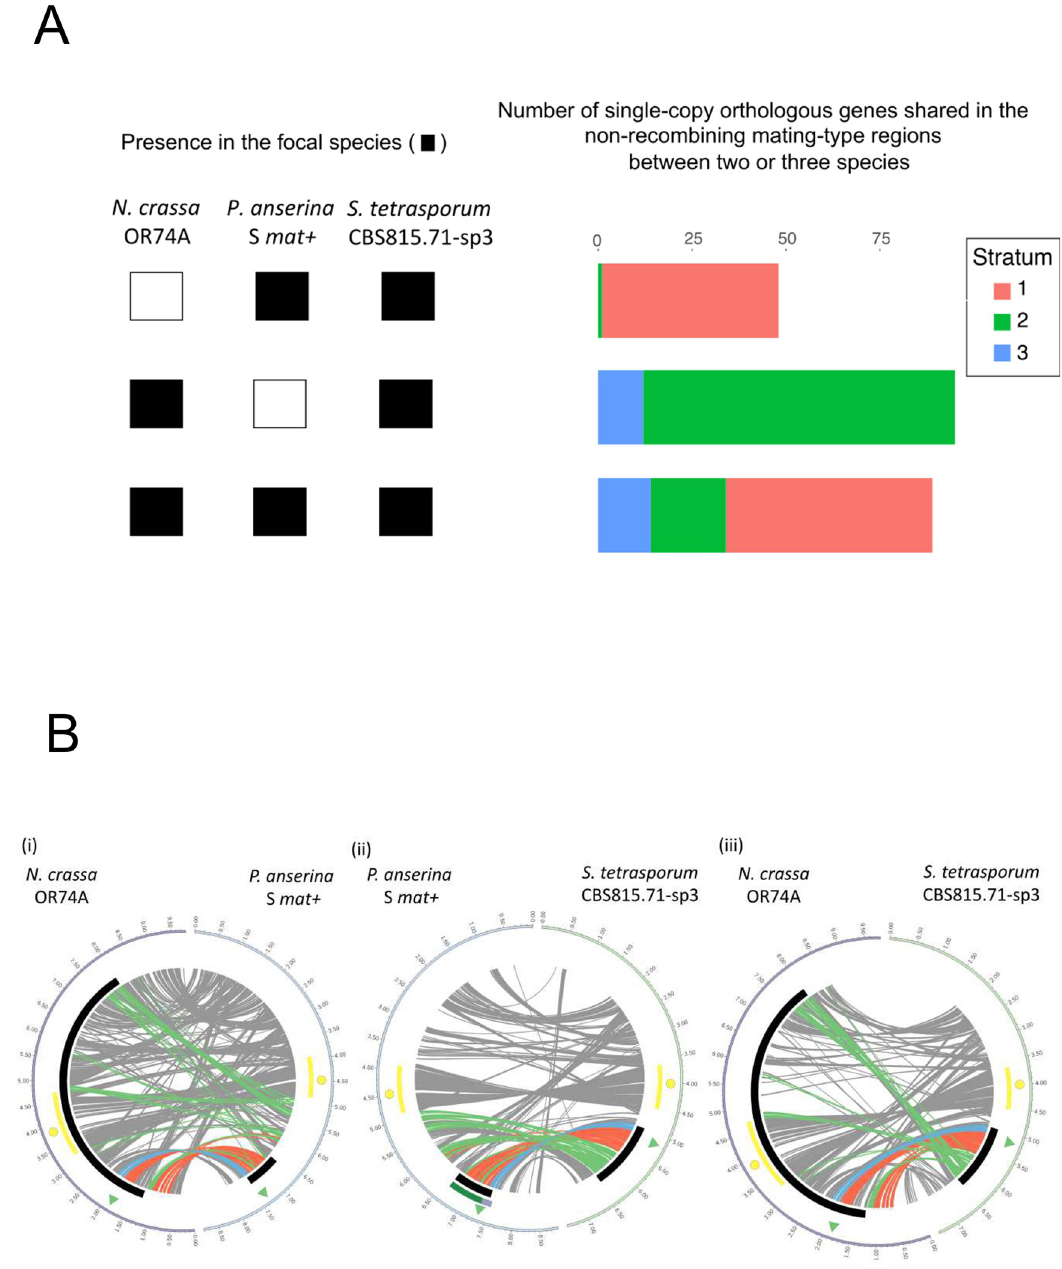
Fig 6. Shared gene content and collinearity between the mating-type chromosomes of Schizothecium tetrasporum , Podospora anserina and Neurospora tetrasperma . A . Number of single-copy orthologous genes present in the non-recombining region of S . tetrasporum that are also in the non-recombining regions of P . anserina and/or N . tetrasperma , as indicated by the squares at the bottom (a filled square indicates the presence in the non-recombining region of the focal species). B. Collinearity between (i) N . crassa (left) and P . anserina (right); (ii) P . anserina (left) and S . tetrasporum (right); (iii) N . crassa (left) and S . tetrasporum (right). Collinearity is based on single-copy orthologous genes. Centromere is indicated with a yellow circle and the region of well- conserved gene order around the centromere is highlighted with a yellow rectangle. The mating-type locus location is shown with a green triangle and the non-recombining region around the mating-type locus in P . anserina [27] and S . tetrasporum with a black track. Along the recombining mating-type chromosome of N . crassa a black rectangle indicates the orthologous region that is non recombining in multiple N . tetrasperma lineages [30]. Red, green and blue links highlight orthologous genes located in the evolutionary strata 1, 2, and 3 of S . tetrasporum , respectively. Grey links indicate other orthologous genes. On panel (ii), the evolutionary strata identified previously in the P . pseudocomata CBS415.72 strain, that is closely related to the P . anserina S strain, are indicated by purple (for the oldest stratum) and dark green (for the youngest stratum) tracks [31], at left.